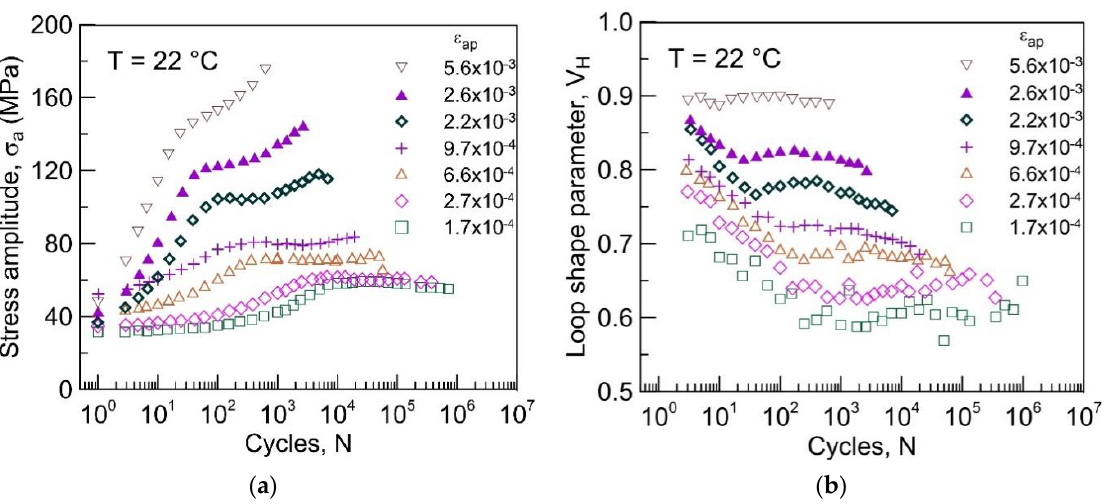
8 of 25 Figure 8. STEM micrographs of precipitation hardened superalloy RENE 41 after 10 cycles with strain amplitude ε a = 8 × 10 −3 ; ( a ) PSM consisting of an extrusion with PSB underneath the surface, ( b ) intensive slip bands (PSBs) shearing the precipitates. The localization of the cyclic strain can be detected by measuring the stress-strain response. Pronounced localization has been detected in copper single crystals [48,49], but it is also found in the polycrystals of simple metals and solid solution alloys. Figure 9 shows the plots of the stress amplitude (Figure 9a) and loop shape parameter (Figure 9b) vs. the number of cycles in constant plastic strain-controlled cycling. The loop shape pa- rameter V H is the ratio of the hysteresis loop area, with respect to that of the circumscribed rectangle. It has been introduced by Mughrabi [48], who studied the stress-strain response of copper single crystal. The cyclic stress amplitude of polycrystalline copper increases in